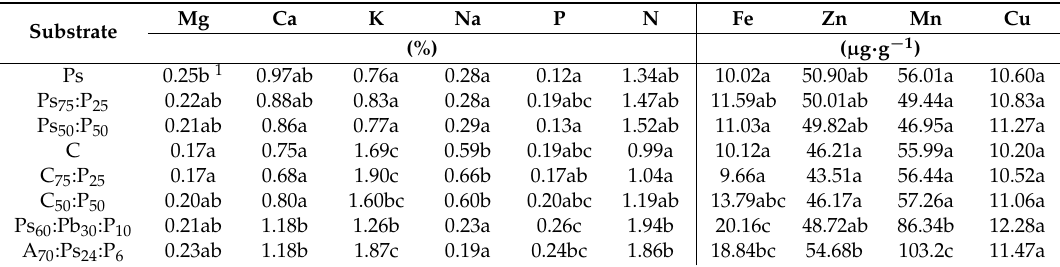
Table 7. Concentration of various macro- and micronutrients in plant tissues of Begonia x elatior , “The President”, at the end of the experiment as affected by the substrate